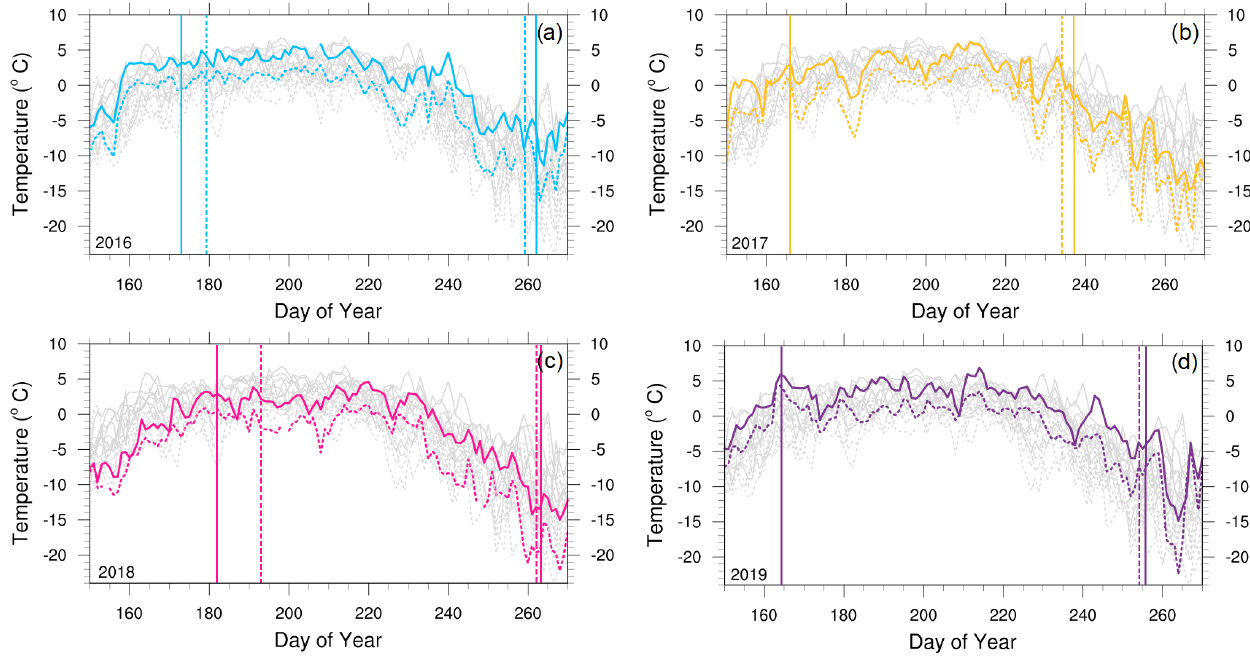
Figure 5. The daily air temperature observations from KPC_L (solid line) and KPC_U (dashed line) from days of the year 150 to 270 for (a) 2016, (b) 2017, (c) 2018 and (d) 2019. Grey lines are daily air temperature from 2009 to 2019 (when available). Vertical solid (dashed) lines represent the opening and closing of SGLs at KPC_L (KPC_U) approximate elevations (information from Table 2).